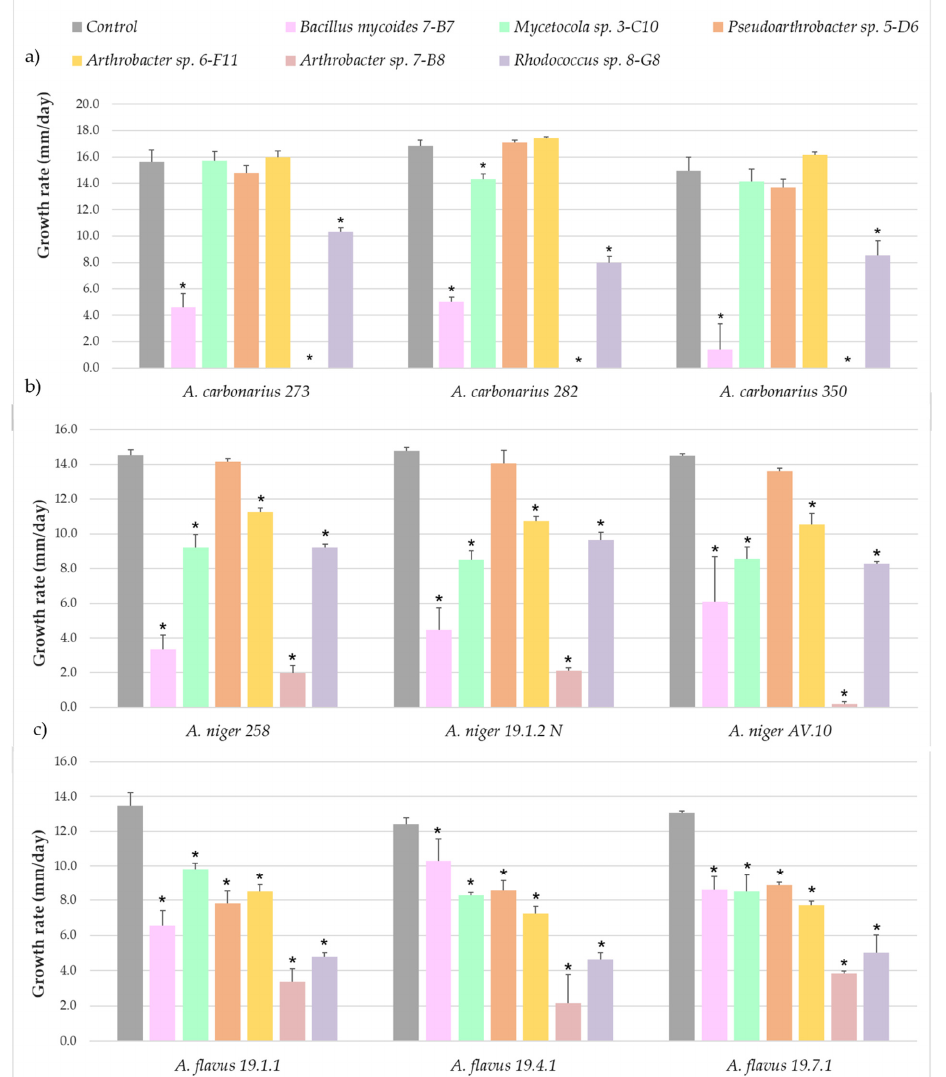
Figure 1. Growth rate of the three strains of ( a ) Aspergillus carbonarius, ( b ), A. niger and ( c ) A. flavus after being co-cultured with the corresponding bacteria. The bars indicate the mean of the three biological replicates and the thin lines their standard deviation values. The asterisks above each bar indicate statistically significant differences with respect to the control generated in Fisher’s LSD test ( p < 0.05).